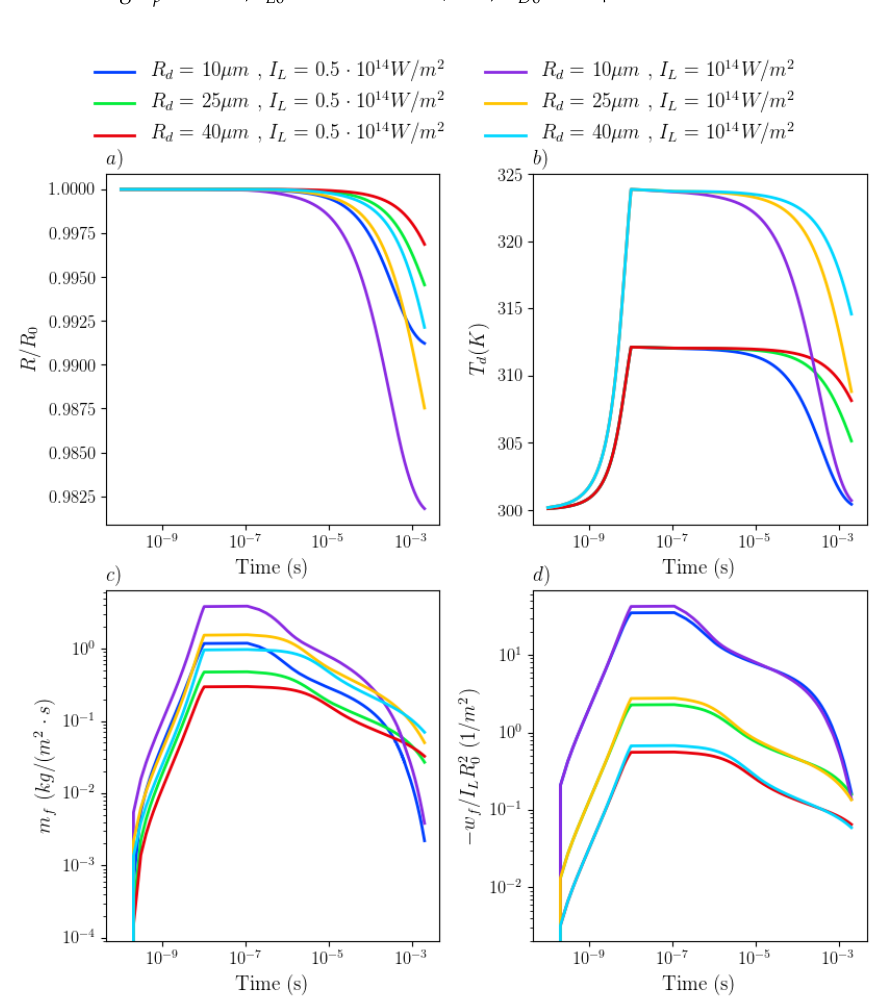
Figure 11. Temporal evolution of ethanol droplet parameters; ( a ) normalized radius, ( b ) droplet temperature, ( c ) evaporation mass flux, and ( d ) conduction and convective heat flux normalized by for cases from Table I L 0 R 2 D